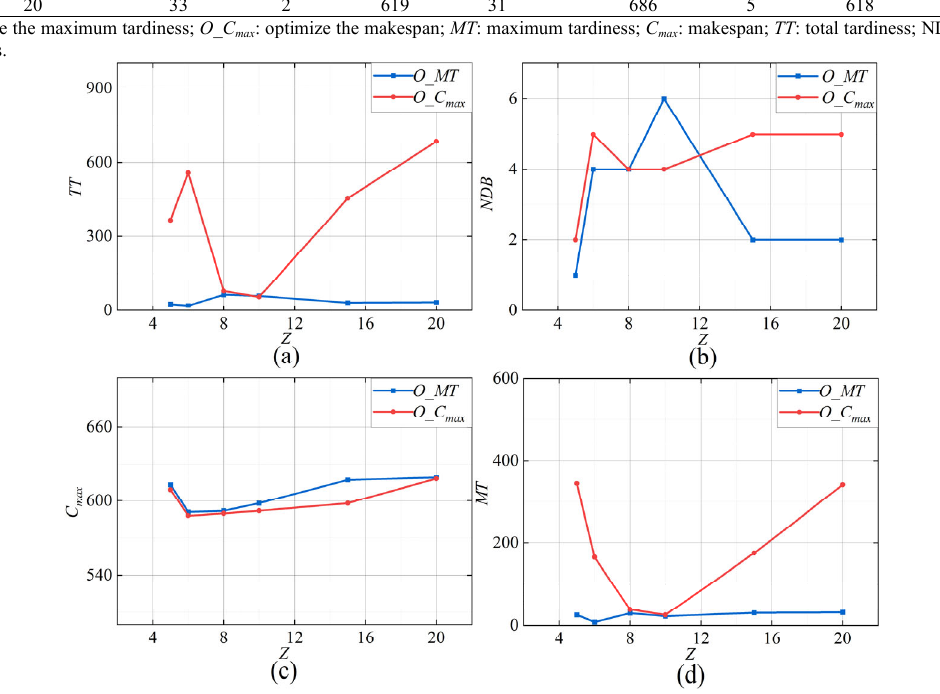
Fig. 1. Performance comparisons of the seru system when maximum tardiness and makespan are the objectives for the instances with 6 product